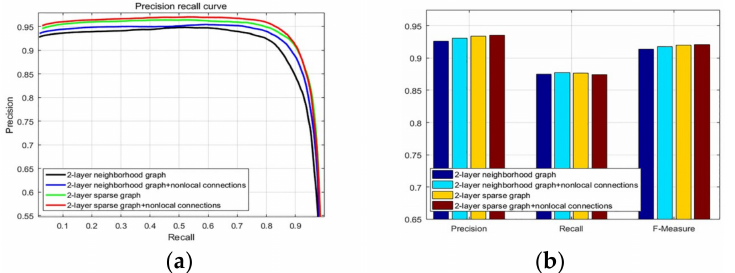
Figure 10. Evaluation of influence of different graph construction methods. ( a ) Precision-recall curves. ( b ) Precision, recall, and F-measure at adaptive threshold.